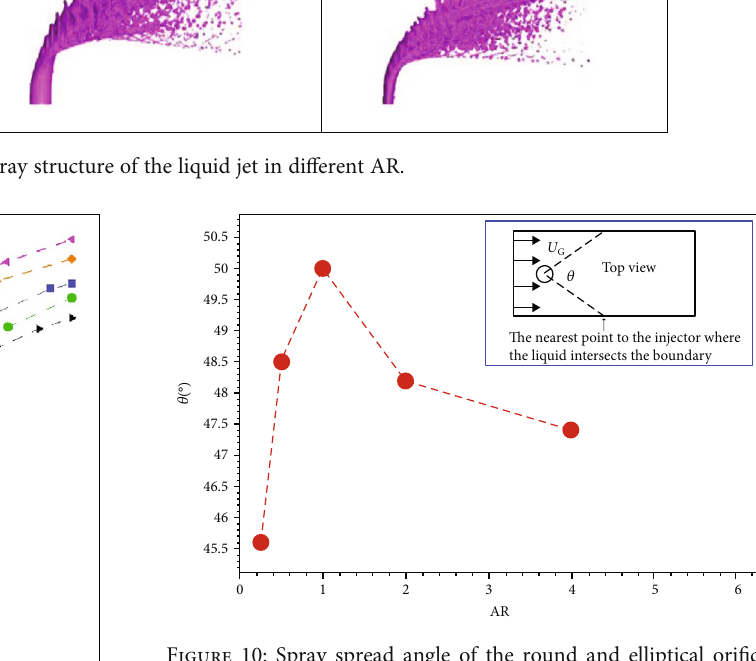
Figure 10: Spray spread angle of the round and elliptical ori fi ce sprays.